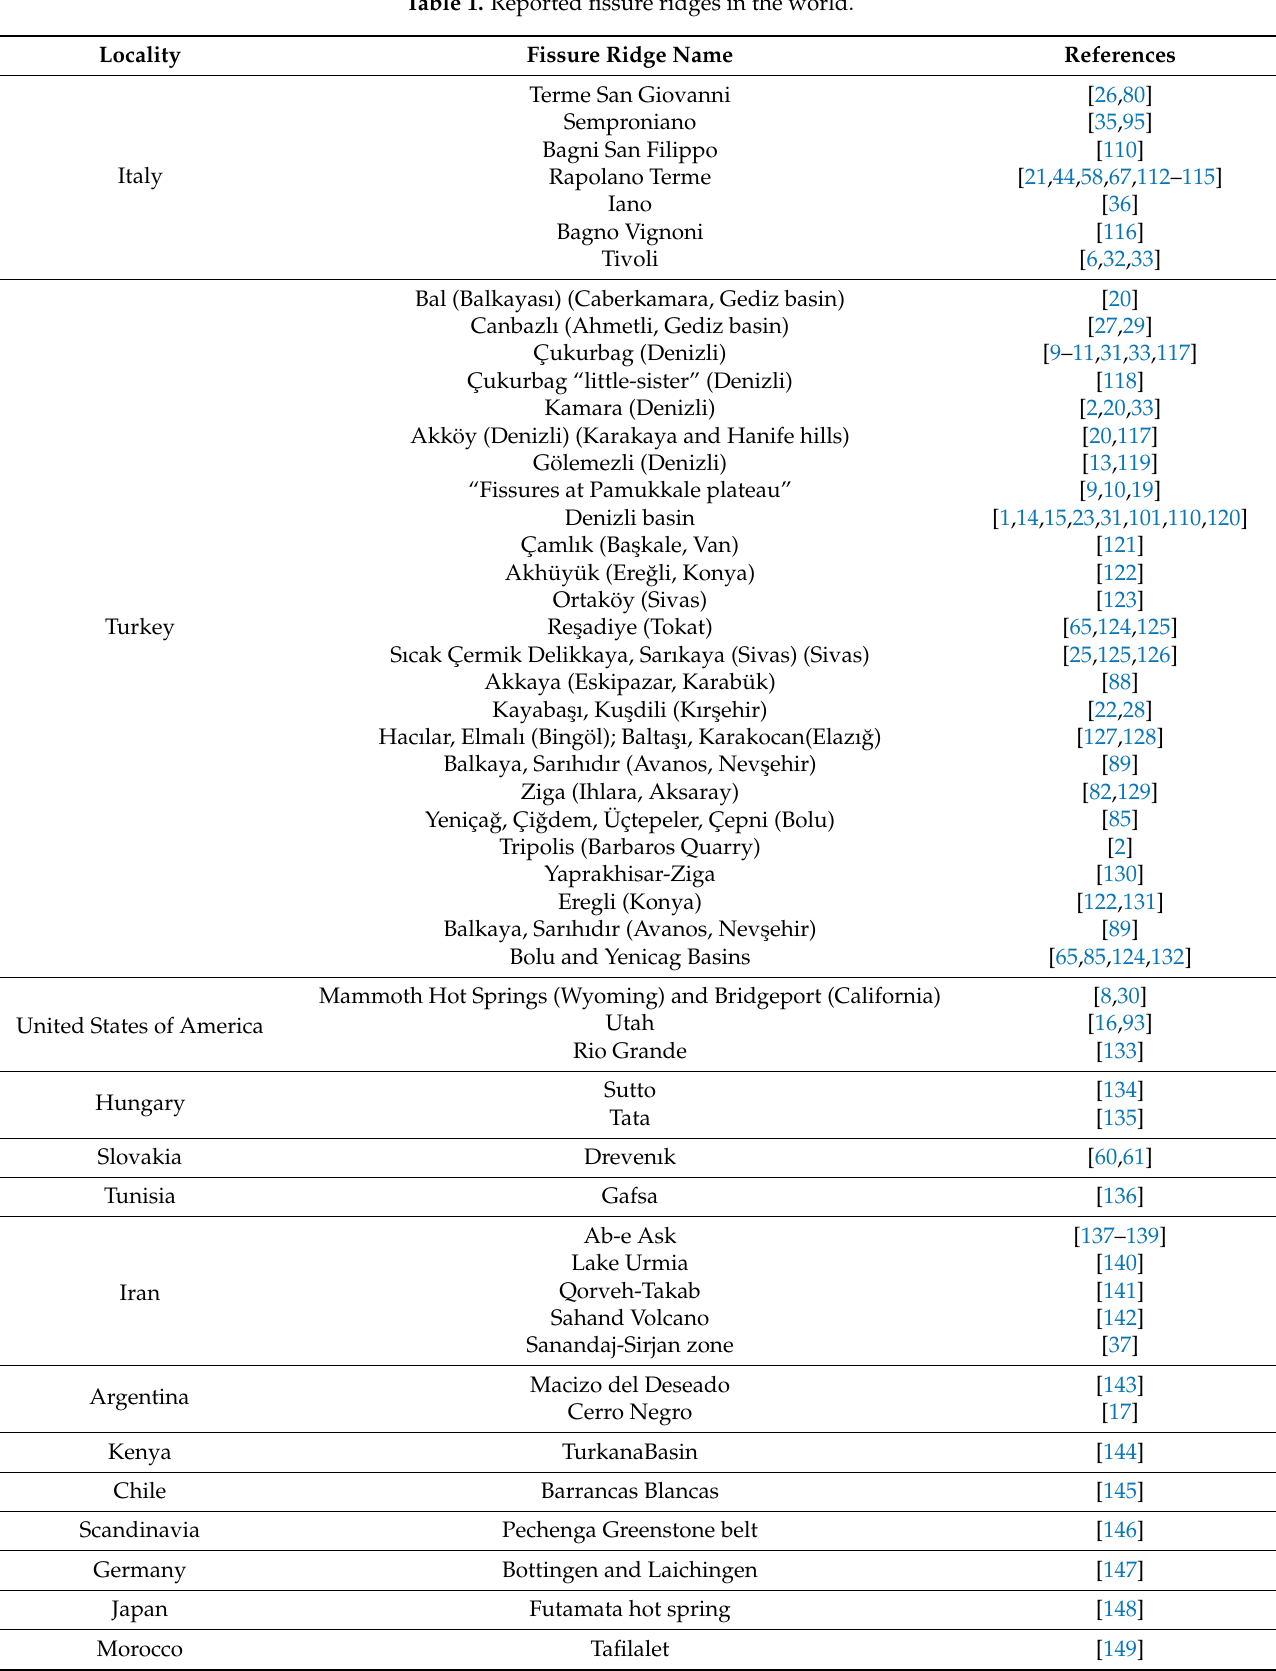
Table 1. Reported fissure ridges in the